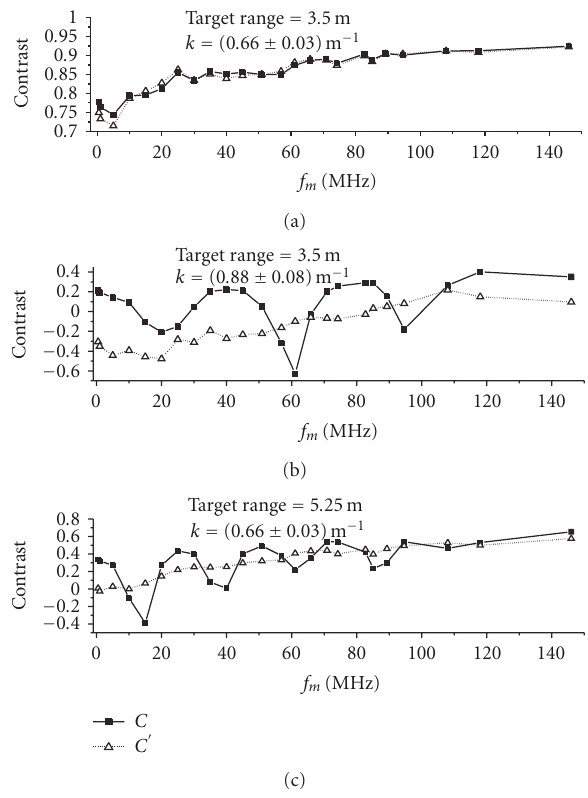
Figure 9: C and C (cid:6) versus f m for (1) z T = 3 . 5m, k = 0 . 66m − 1 , η = 0 . 08, τ = 2 . 31 (a); (2) z T = 3 . 5m, k = 0 . 88m − 1 , η = 1 . 5, τ = 3 . 08 (b); (3) z T = 5 . 25m, k = 0 . 66m − 1 , η = 0 . 6, τ = 3 . 465 (c). Note the general growing tendency of C and C (cid:6) for increasing f m .